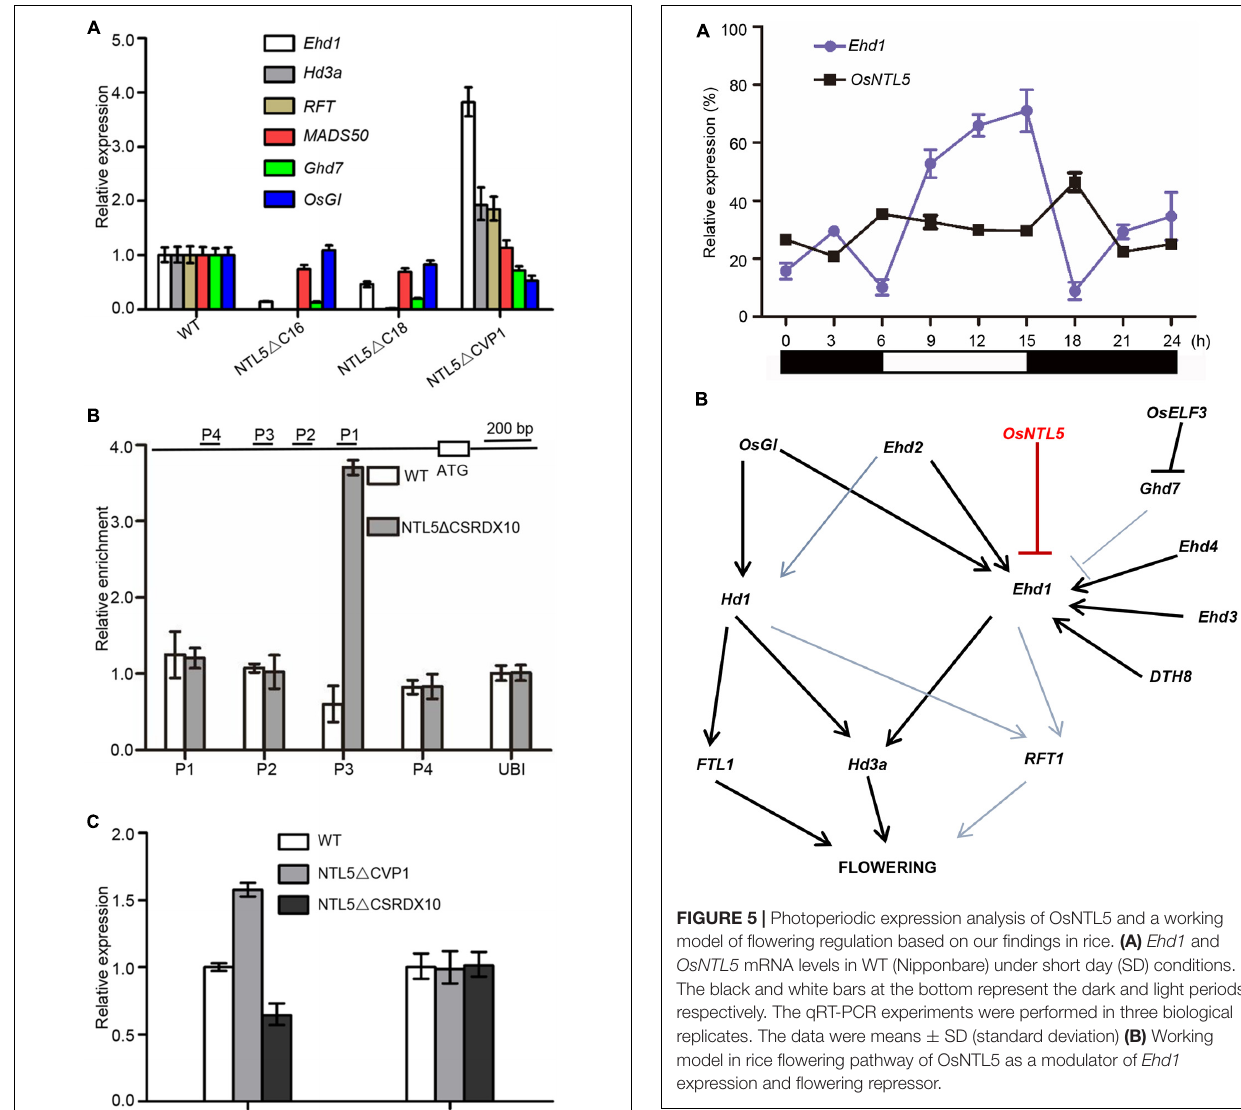
plants like Arabidopsis thaliana . NAC transcription factors